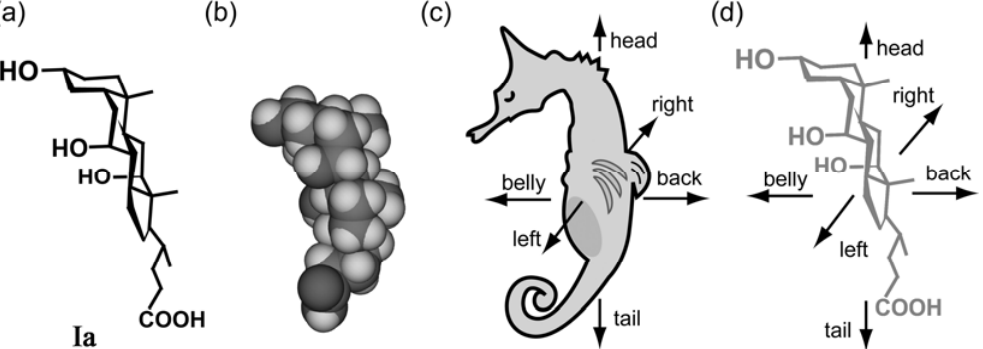
Figure 15. A stereostructure of Ia (a), its space-filling model (b), a hypothetical animal (c), and a stereostructure of Ia with three-axial chirality